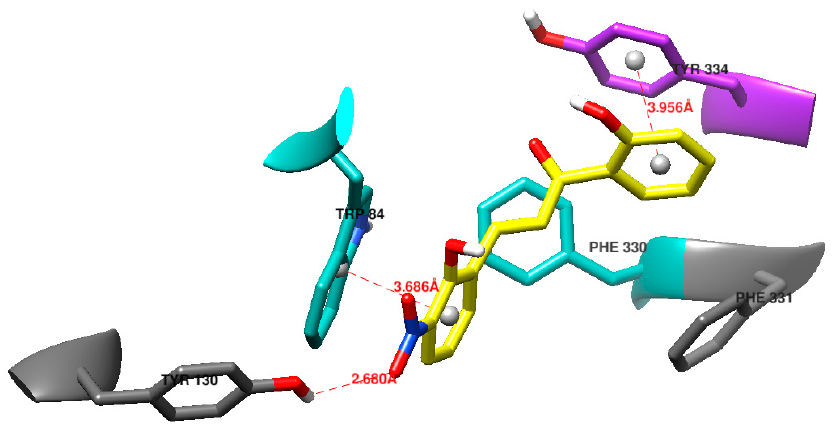
Figure 4. Chalcone 2d and its interactions with nearby residues.